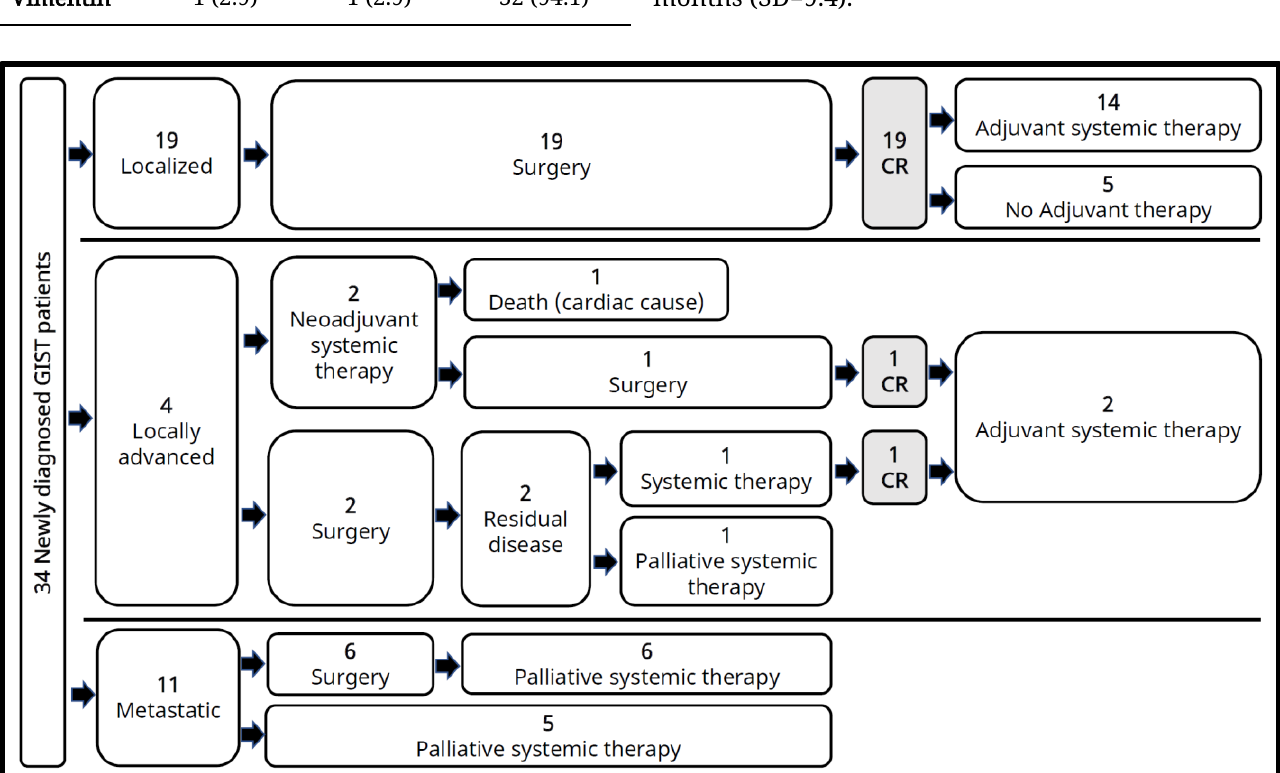
disease received neoadjuvant imatinib 400 mg daily. One of them with a rectal primary achieved adequate tumor response, which was followed by sphincter sparing R0 resection then adjuvant imatinib for 2 years. Later, this patient developed distant metastasis for which imatinib was re- started. The other patient with a gastric primary died 5 months after starting treatment due to a cardiac cause. Among the 21 patients who achieved complete remission (CR), 16 patients received adjuvant imatinib 400 mg daily for a mean duration of 14.9 months (SD=9.4).